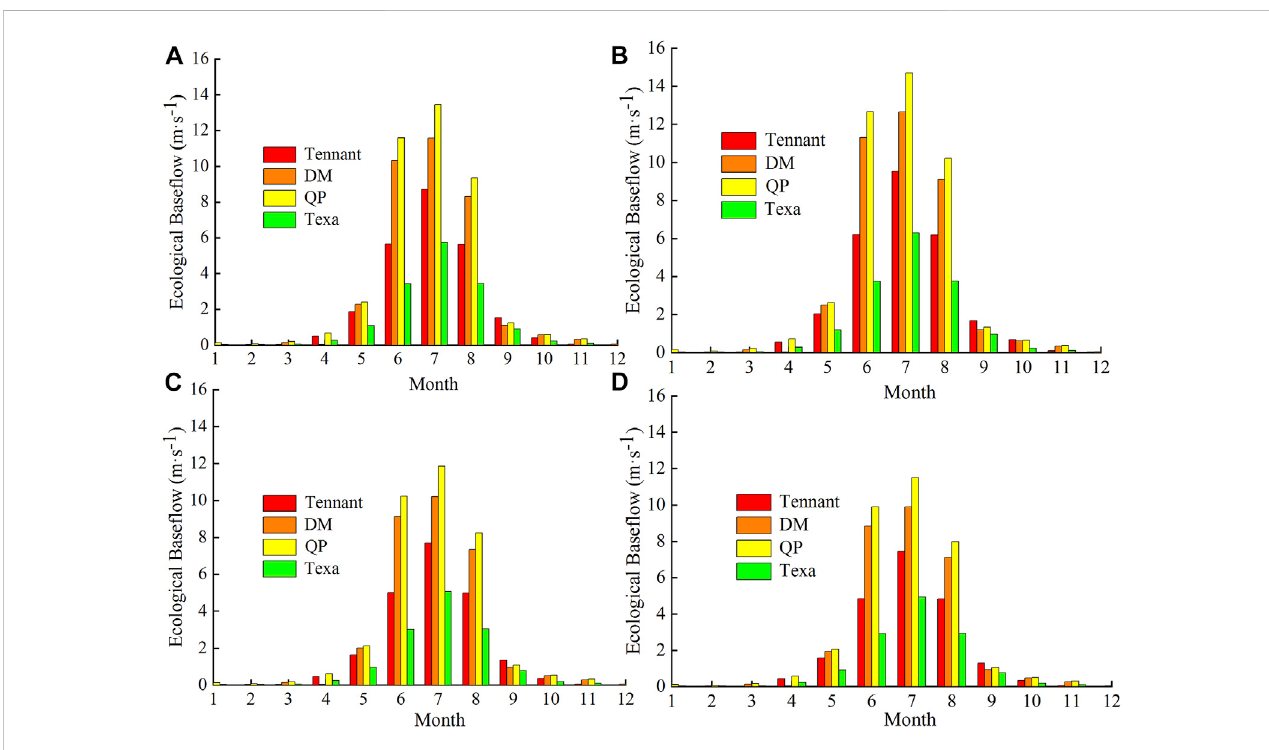
FIGURE 2 Four methods are used to calculate the multiyear average monthly ecological base fl ow of the four sections. (A) Niya Reservoir. (B) 818 Canal. (C) Niya Station. (D) Niya Canal.